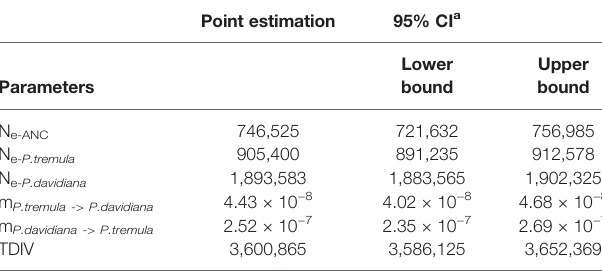
FIGURE 4 | Best- fi tting model inferred demographic histories and differentiation mode for P. davidiana and P. tremula implemented by fastsimcoal 2.6.1. TABLE 2 | Demographic parameters and con fi dence interval of the best